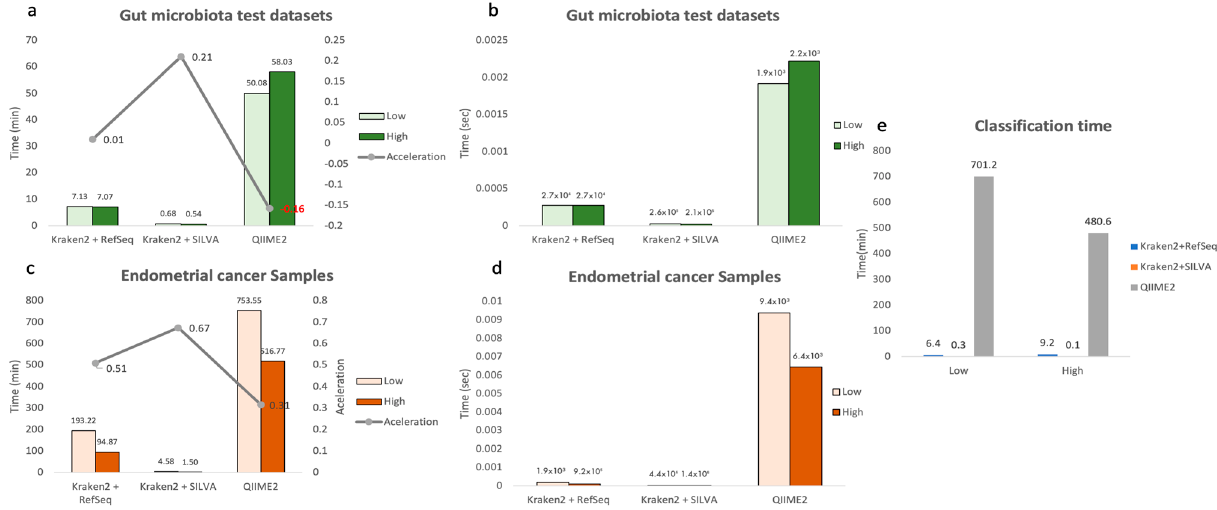
Figure 13. Computational times . ( a , c ) Total execution time, in minutes, for each pipeline (Kraken, QIIME), database (RefSeq, SILVA132) and computational profile described (low, high), for both the endometrial cancer dataset ( a ) and the gut microbiota test dataset ( c ). These two figures also show, with a grey line, the acceleration values obtained when switching from the low to the high profile. ( b , d ) Average processing time per read used by each pipeline. This was calculated by dividing the total time by the number of reads analysed in each run. ( e ) Time used to classify the reads in the database. The times referring to Kraken refer to the average classification time for each sample, as this processing can be parallelised. However, in the case of QIIME, the time spent for all samples is represented, since, as mentioned above, this process is executed in a linear way in Nextflow.